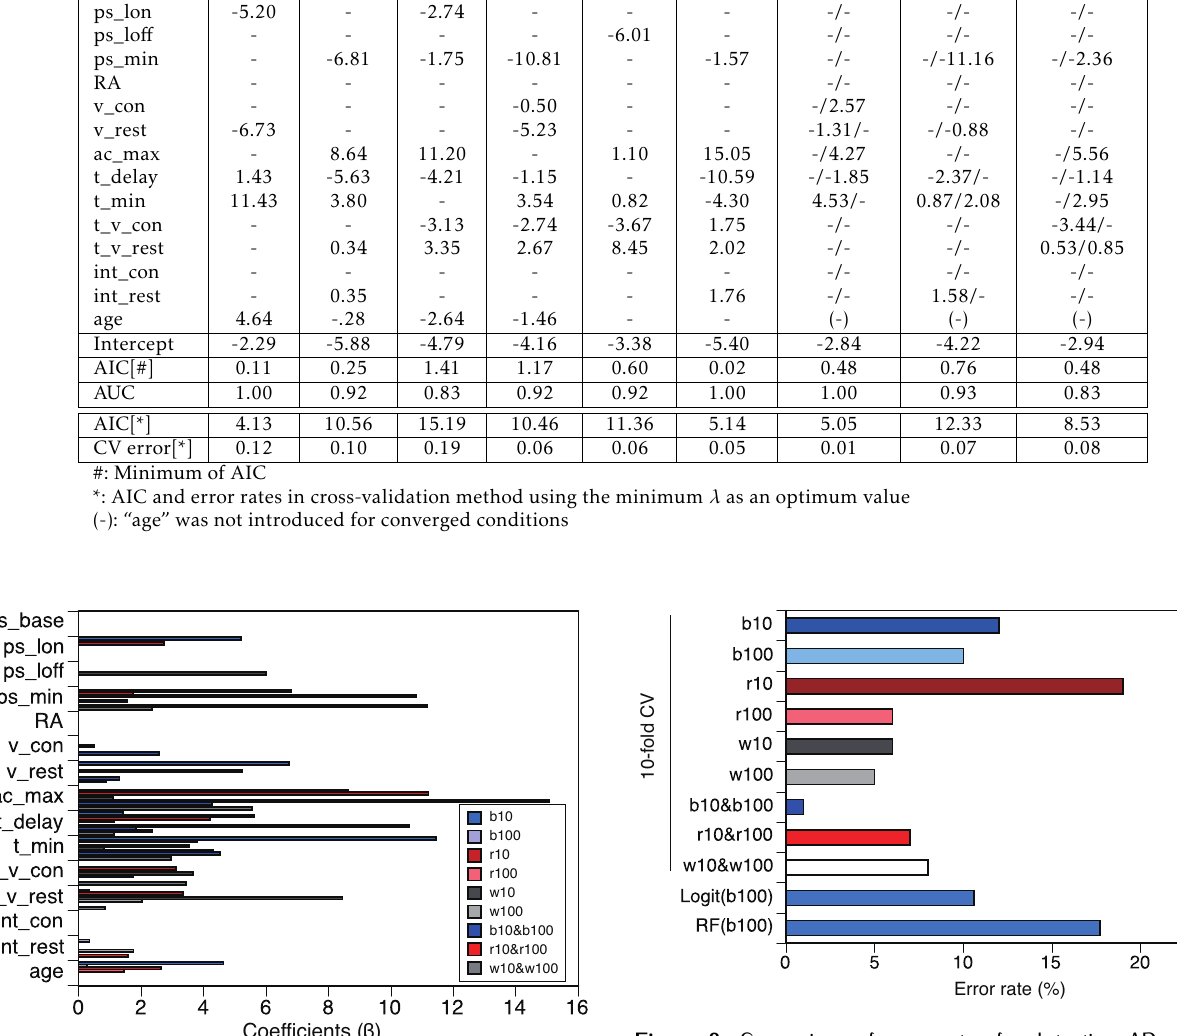
Figure 8. Comparison of error rates for detecting AD patients (Logit: previous section, RF: performance using Random Forest